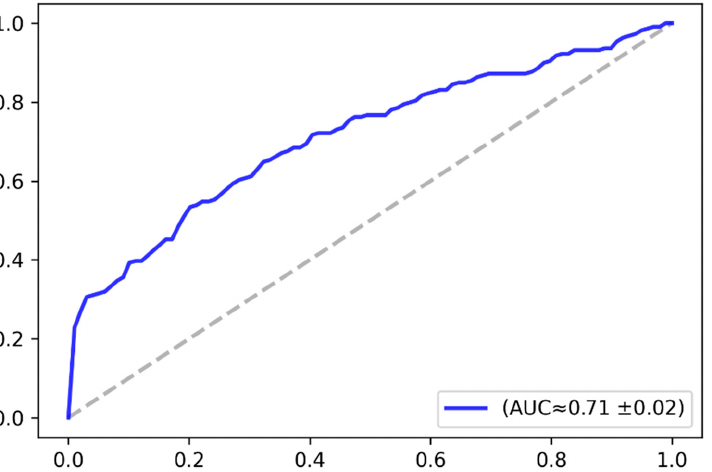
Figure 9. Receiver operating characteristics (ROC) curve-baseline model (no data augmentation).